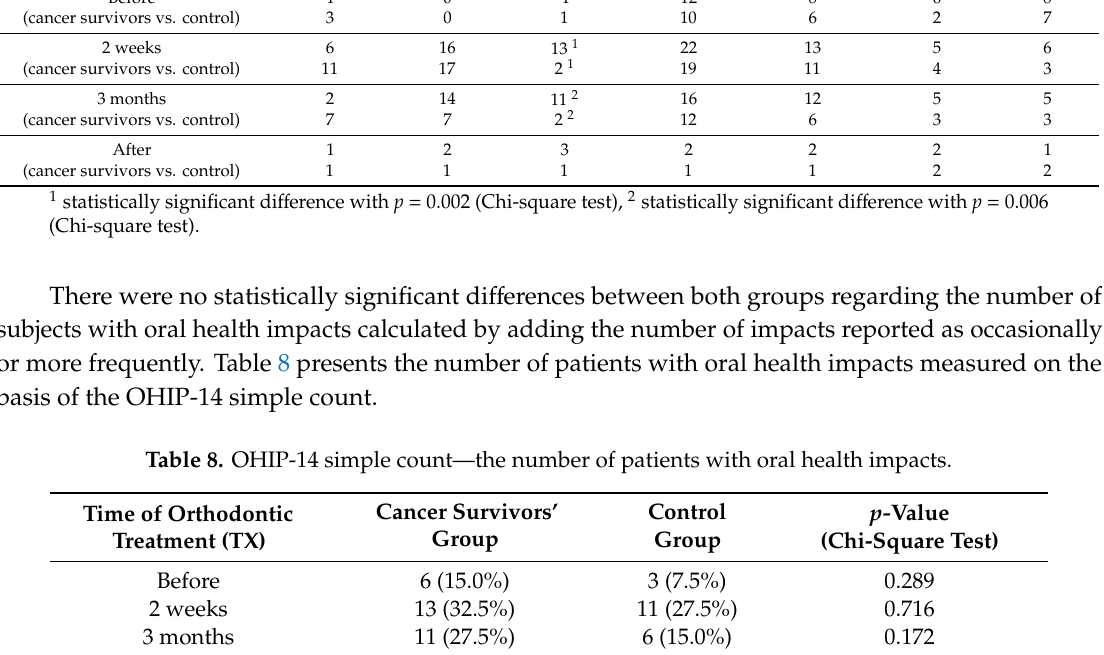
Psychological Disability 8 6